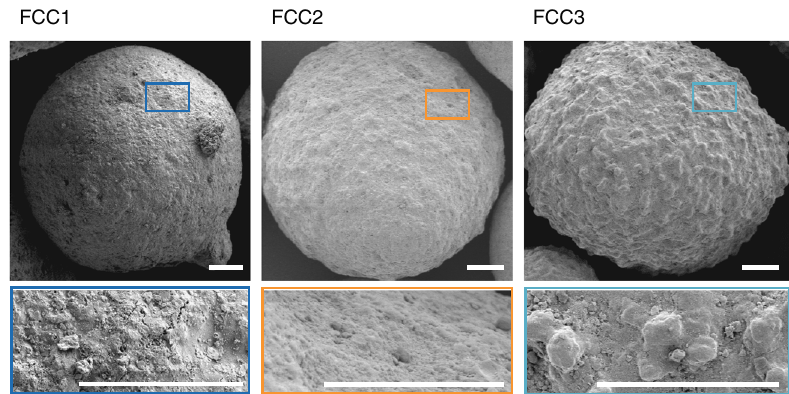
Fig. 1 Electron micrographs of FCC catalysts. Shown are scanning electron micrographs of an FCC1, FCC2, and FCC3 particle. Highlighted is the morphological transition with catalytic deactivation. Scale bars are 10 µ